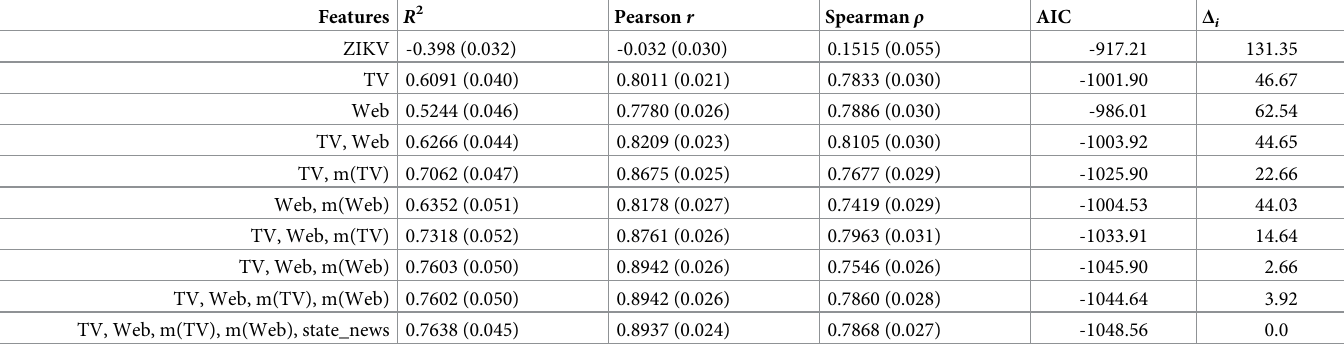
= AIC for model i i − AIC min